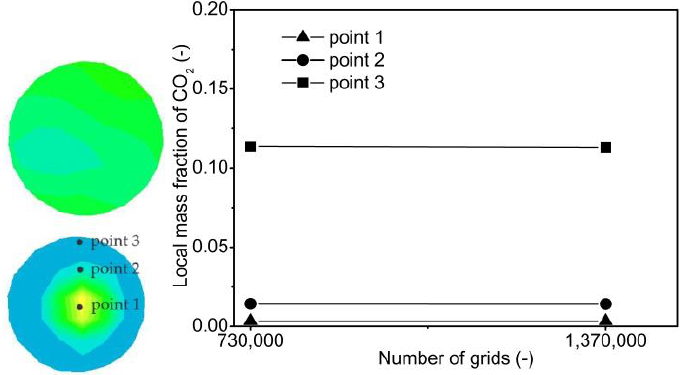
Figure 4. Independent validation of grid numbers with the local mass fraction of CO 2 at the outlet of intake port 1.